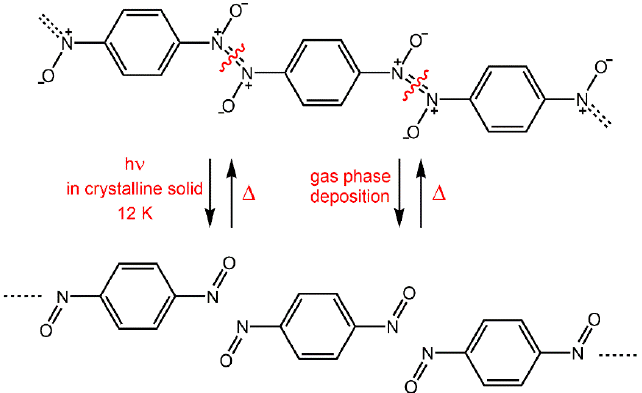
Figure 9. Preparation of p -dinitrosobenzene by cryogenic photolysis of the corresponding polymer and by the gas phase cryogenic